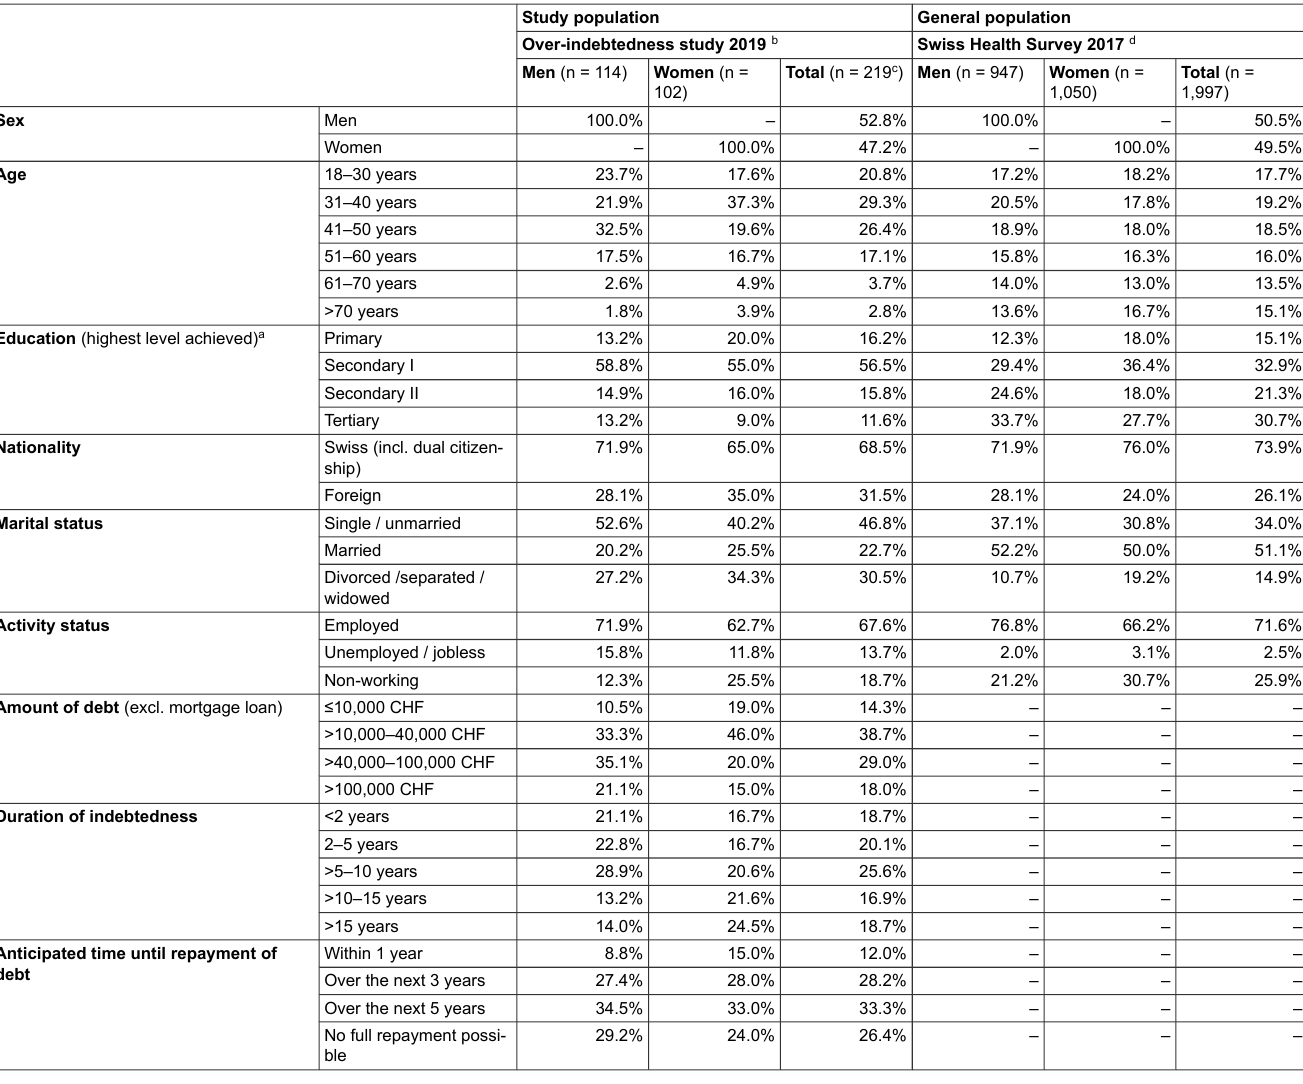
Table 1: Characteristics of the study population (n = 219) stratified by sex and compared to the general adult population of the canton of Zurich (n =